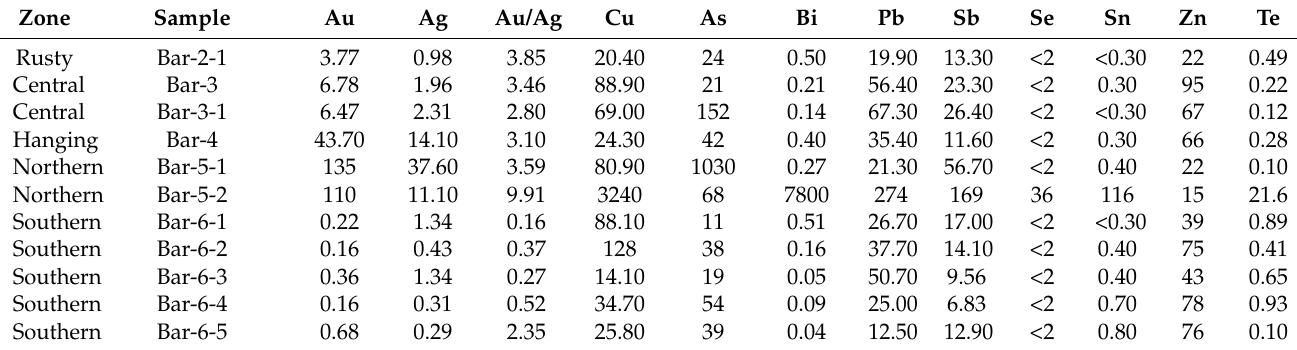
Table 6. Concentration of ore and chalcogenic elements in rocks of different zones of the Baranyevskoe deposit, ppm.